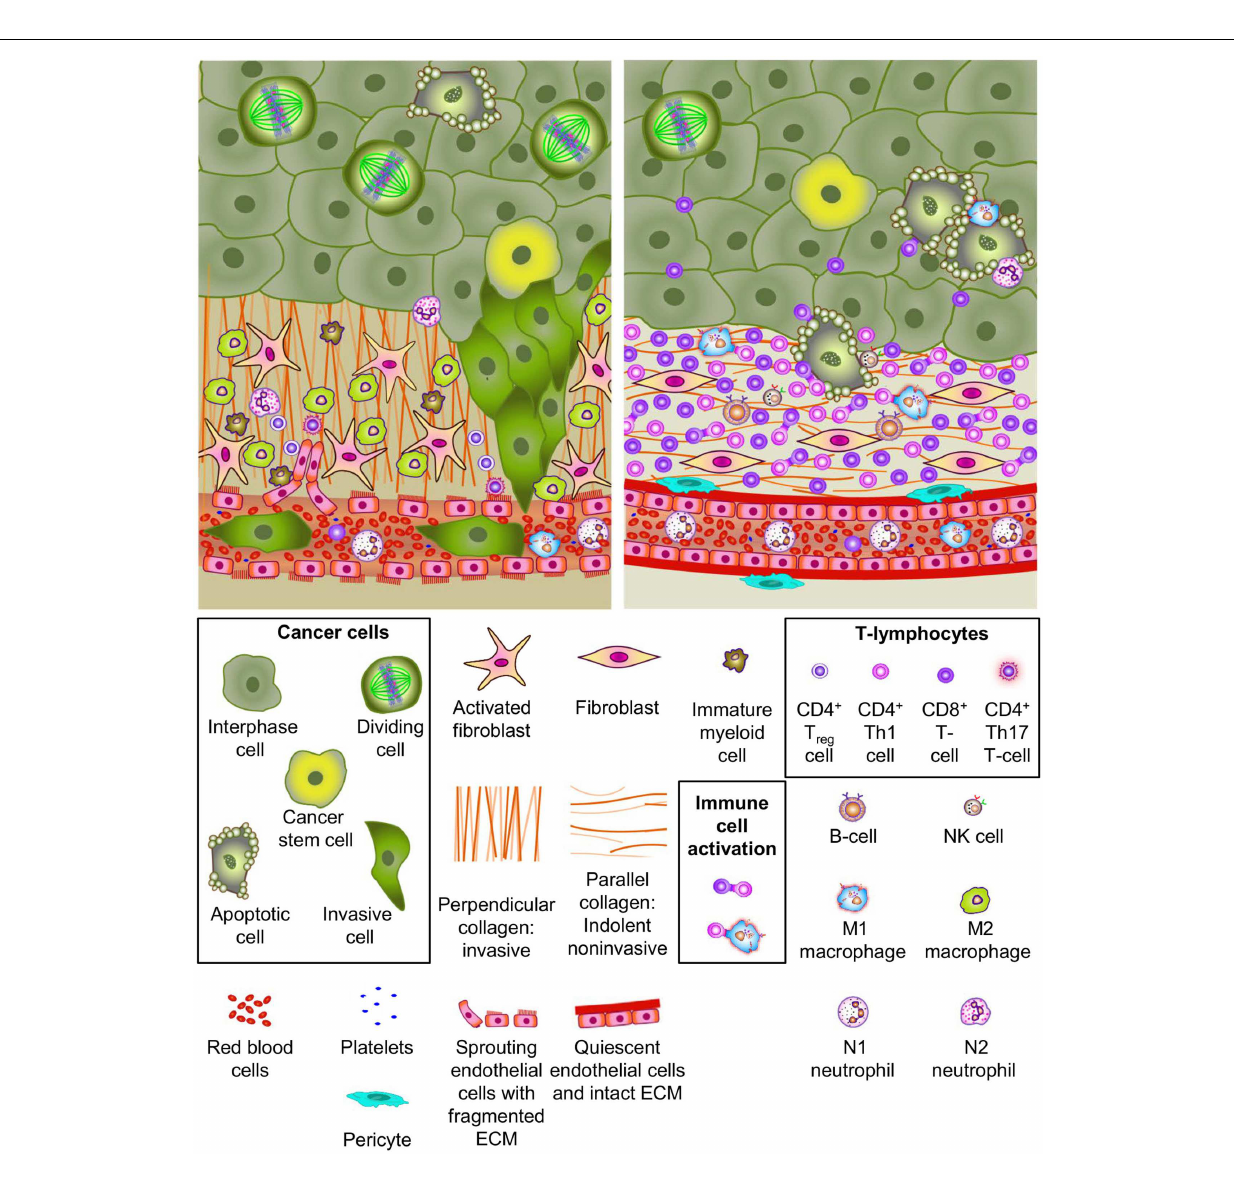
FIGURE 1 | Cellular heterogeneity in the tumor and microenvironment . Most solid tumors grow in a complex micro-environment consisting of stromal cells, vasculature, infiltrating immune cells, and complex extracellular matrix (ECM) components. Cell types and ECM components are identified in the legend.The upper left panel depicts many elements reported in association with tumor promoting micreoenvironments.This environment exhibits tumor promoting characteristics including (1) paracrine signaling axes between tumor cells, stromal cells, vascular cells and immune cells, (2) neoangiogeneis with porous/leaky vascular ECM, (3) reactive stroma, (4) ECM remodeling, and